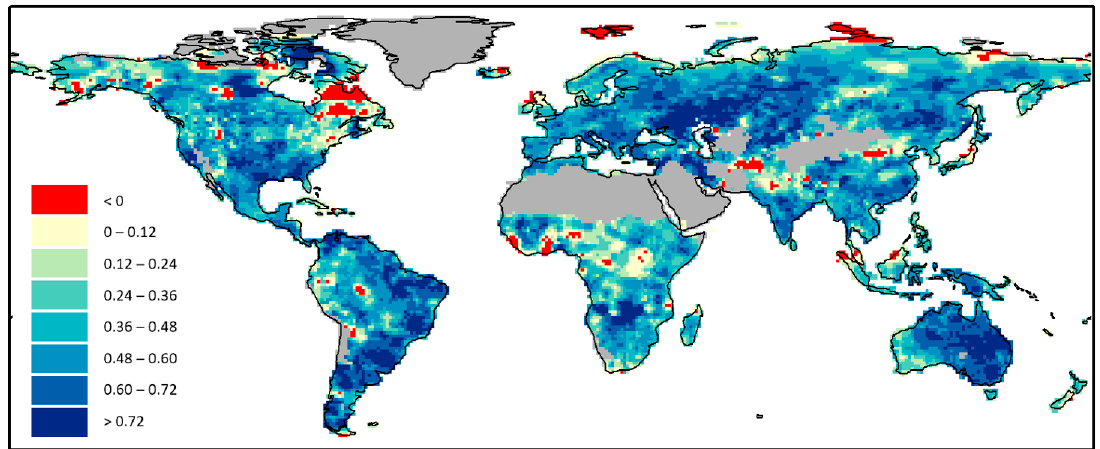
Figure 3. Spatial distribution of the maximum R between SPI and TWSA obtained from the optimal SPI-n. Masked cells (where liquid rainfall was < 100 mm annum) are represented in grey. Figure 4. Spatial distribution of the SPI accumulation period returning the maximum R between SPI and TWSA. Masked cells (where liquid rainfall was <100 mm annum) are represented in grey.